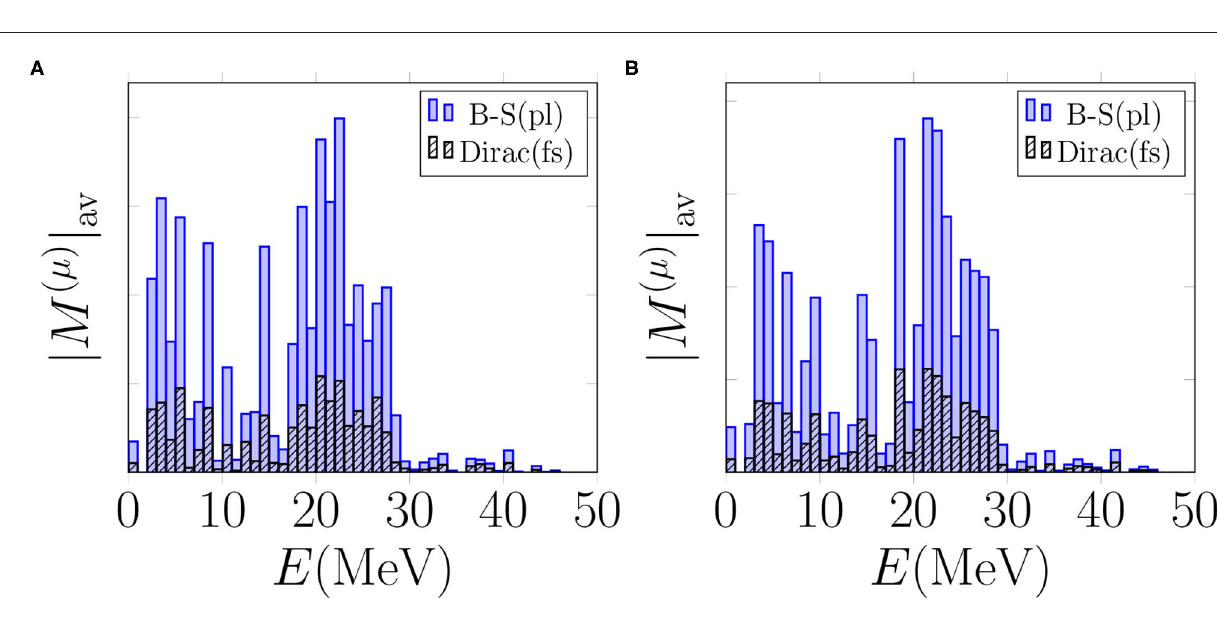
element is more evenly distributed to a few leading